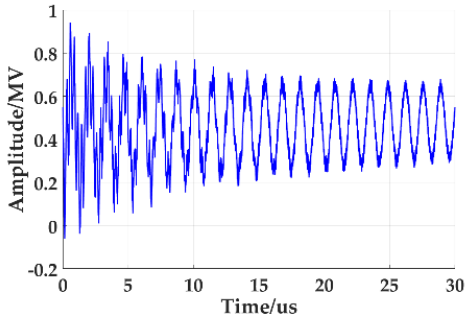
Figure 4. Waveform of VFTO injection transformer front end.